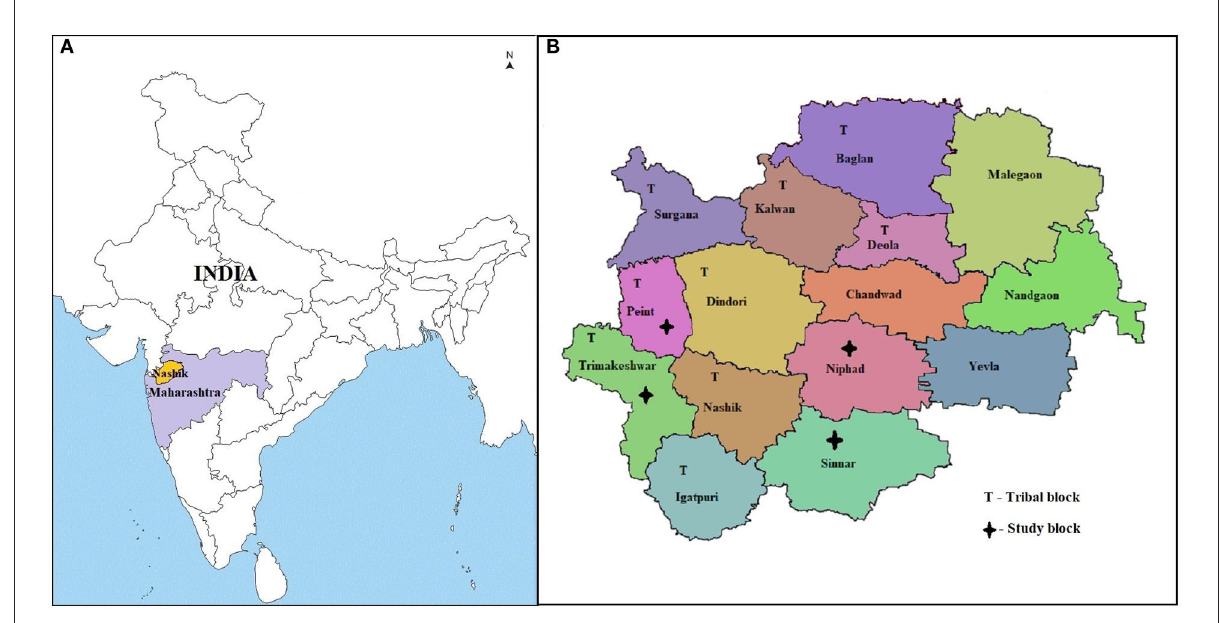
FIGURE1 Map of India showing the location of the study area, 2018-19. (A) India showing the location of selected Nashik district, State Maharashtra (B) Nashik district with selected study blocks. Source: Maps of India freely available and accessible at www.mapsofindia.com.